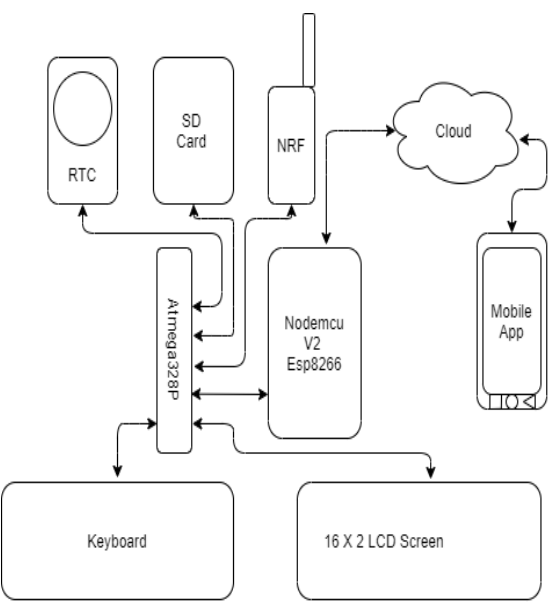
Figure 2.4 . Block diagram of the base